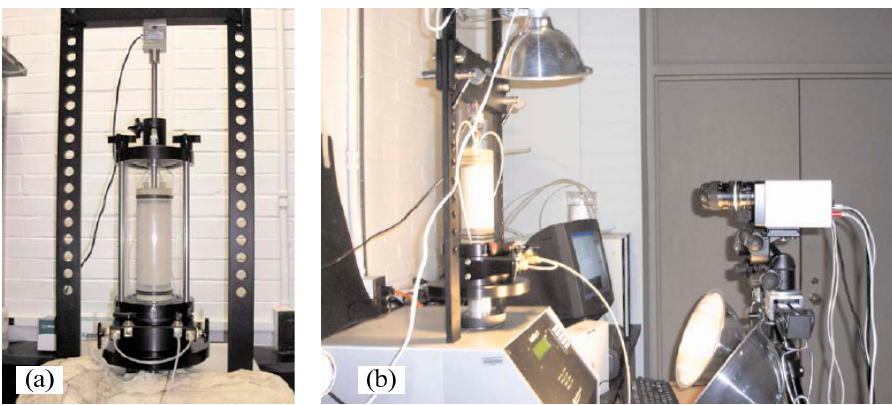
Figure 1. Triaxial Geocomp and 3D imaging systems [34] ( a ) front view ( b ) side view with cameras.